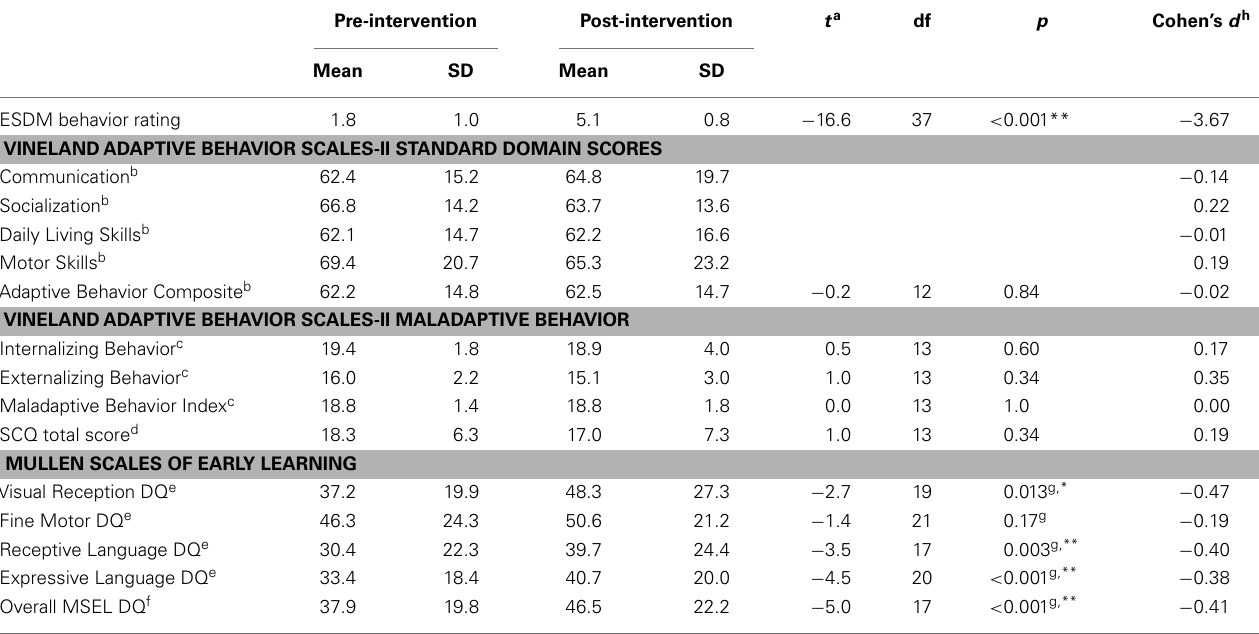
Table 1 | Pre- to post-intervention scores in a cohort of preschoolers treated with group ESDM